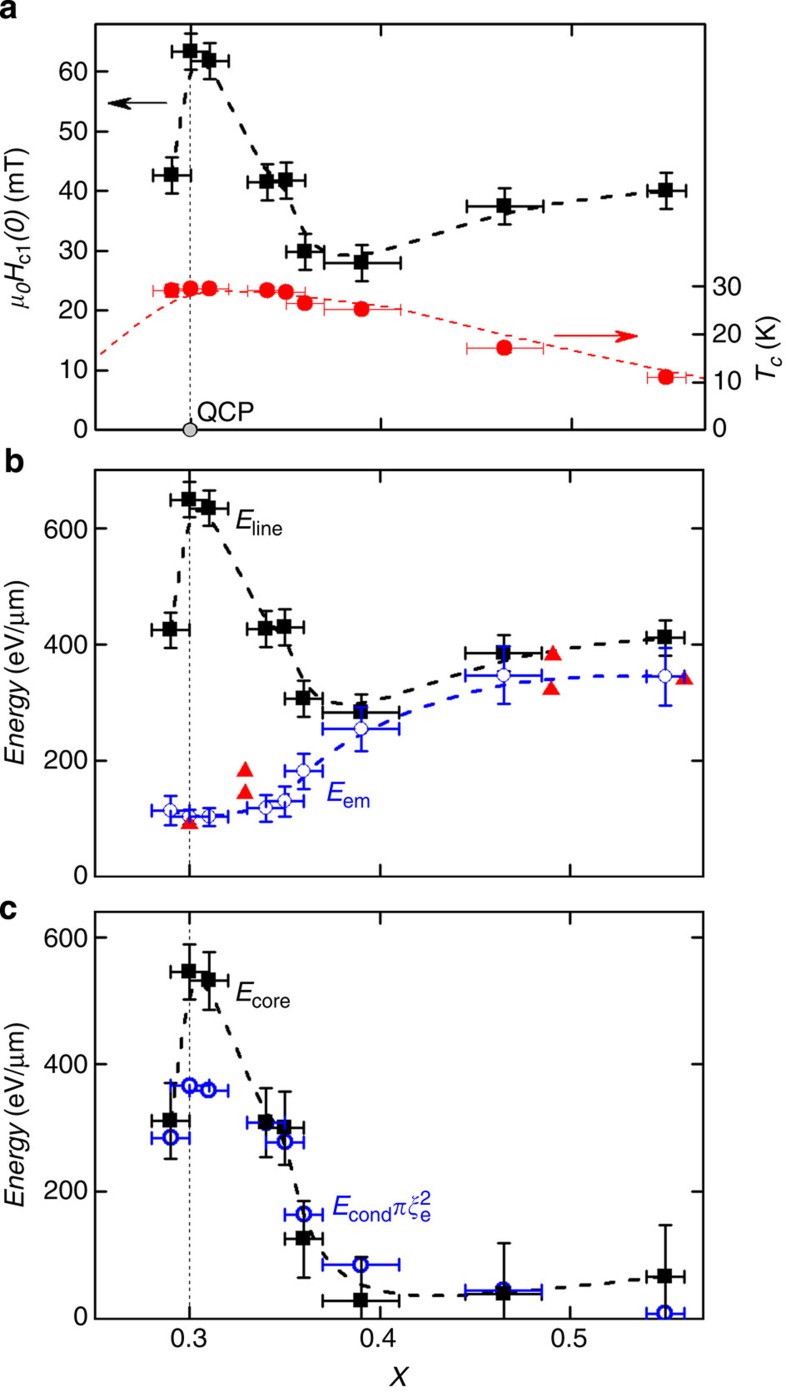
Concentration x dependence of lower critical field and associated energies for BaFe2(As1−xPx)2.(a) Lower critical field Hc1 extrapolated to T=0 and Tc. The location of the QCP is indicated. Error bars on Hc1 represent the combination of uncertainties in extrapolating Hc1(T) to T=0 and in the demagnetizing factor. Error bars on x are s.d. (b) Vortex line energy Eline=Eem+Ecore at T=0 from the Hc1(0) data and equations (4) and (3) shown as squares. The electromagnetic energy calculated using equation (4) and different estimates of λ are also shown. The triangles are direct measurements from ref. 9, and the circles are estimates derived by scaling the band-structure value of λ by the effective mass enhancement from specific heat 10. Error bars on Eem (circles) are calculated from the uncertainty in jump size in heat capacity at Tc. (c) Vortex core energy Ecore=Eline−Eem along with an alternative estimate derived from the specific heat condensation energy (Econd) and the effective vortex area (πξe2). The uncertainties are calculated from a combination of those in the other panels. The dashed lines in all panels are guides to the eye.